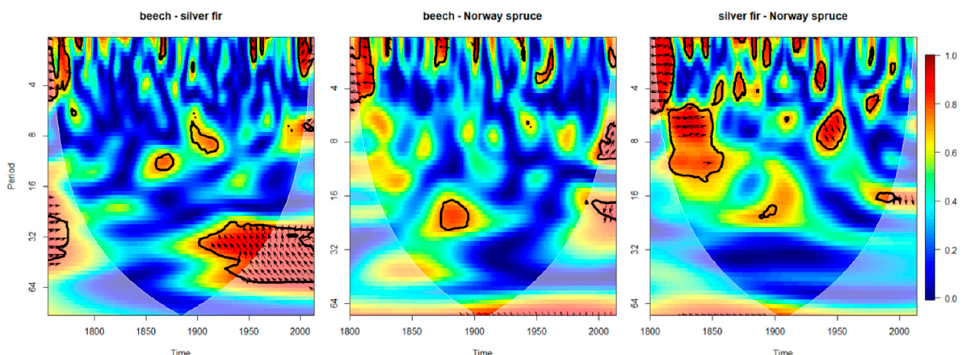
Figure 3. Dendrochronological biwavelet between species, after 100 Monte Carlo randomizations. Arrows direction indicate that both dendrochronological series are in phase (pointing to the right ) or anti-phase (pointing to the left ), the black contour indicates ≤ 0.05 significance, and the transparency, the cone of influence.